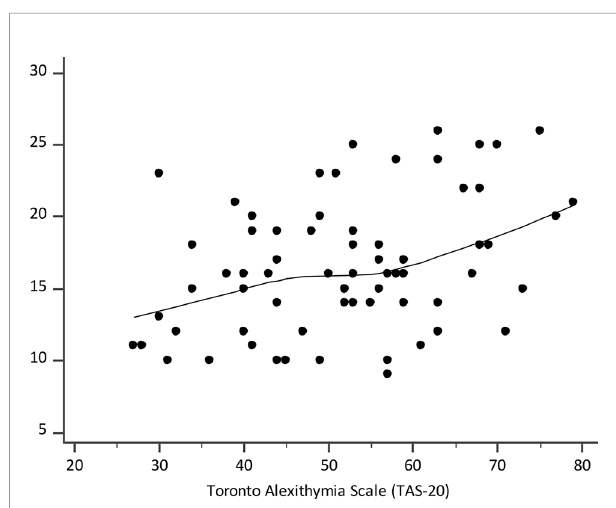
FIGURE 1 | Scatter diagram of correlation between the Toronto Alexithymia Scale (TAS-20) and the Panic Disorder Severity Scale (PDSS); the line is a locally estimated scatterplot smoothing (LOESS) trend-line with the smoothing span of